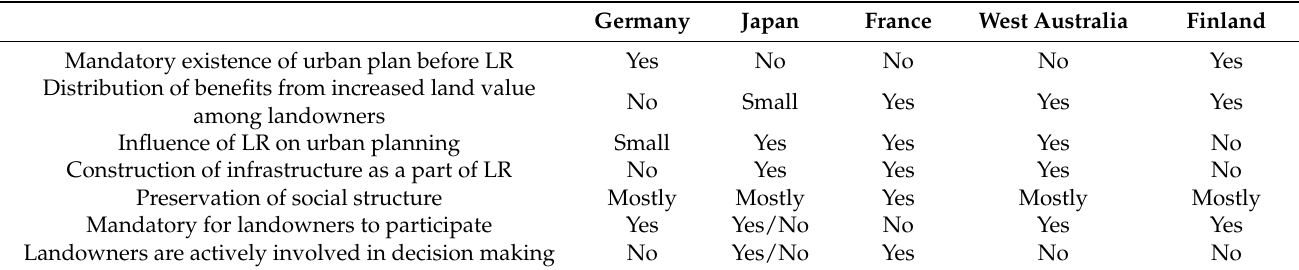
Table 1. Summary of differences in LR